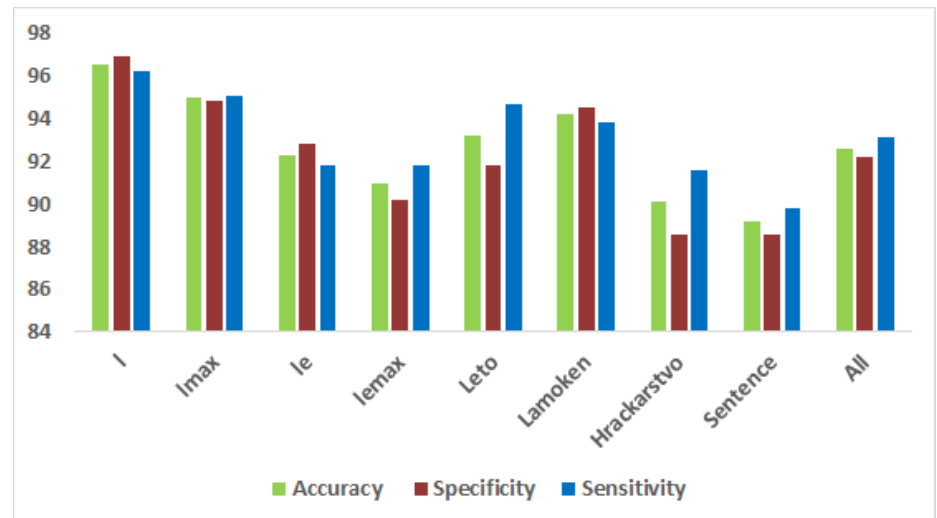
Figure 3. Comparison results of accuracy, specificity and sensitivity for various tasks.